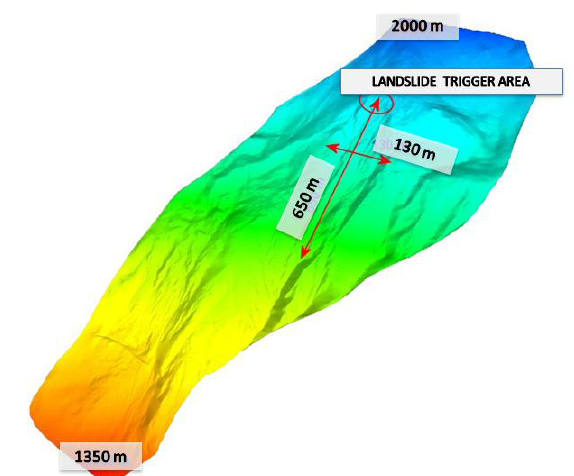
Figure 3. DTM model of the area with false colors